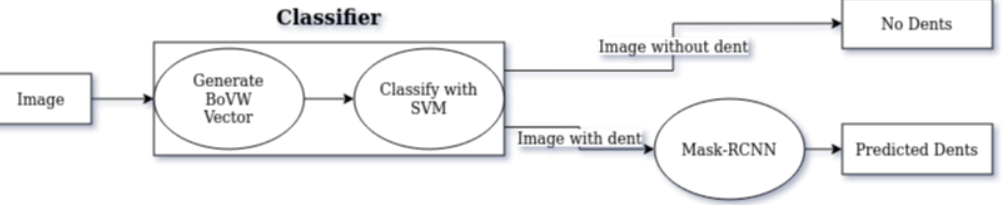
Figure 4. Visualization of the pre-classification approach.